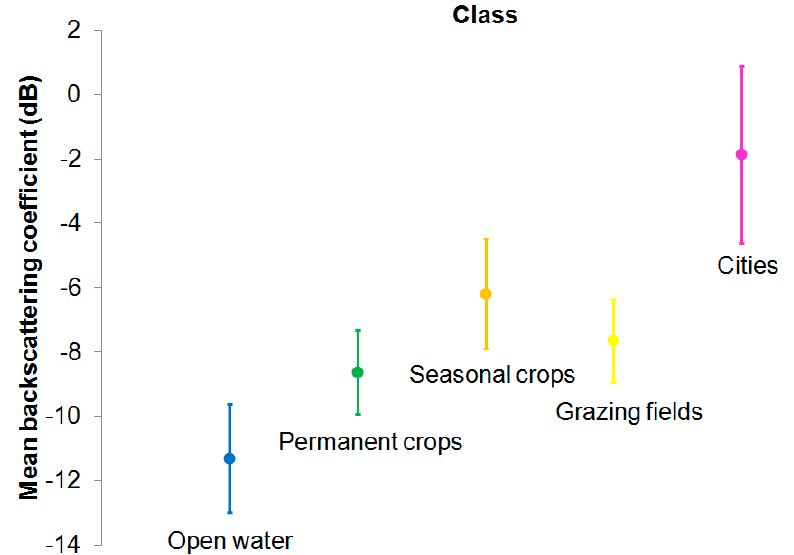
Figure 6. Average backscattering coefficient (dB) and associated standard deviation (dB) for each class resulting from a k ‐ nearest neighbors supervised classification performed during the dry season (July– (orange), grazing fields (yellow), cities